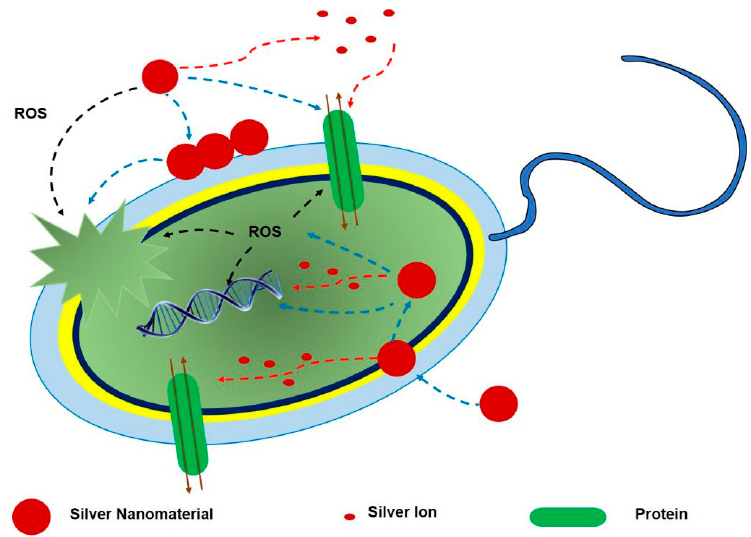
Figure 7. The comprehensive mechanism of antibacterial activity of Ag NPs. Reproduced with permission from Reference [55]. Copyright 2018, John Wiley and Sons.